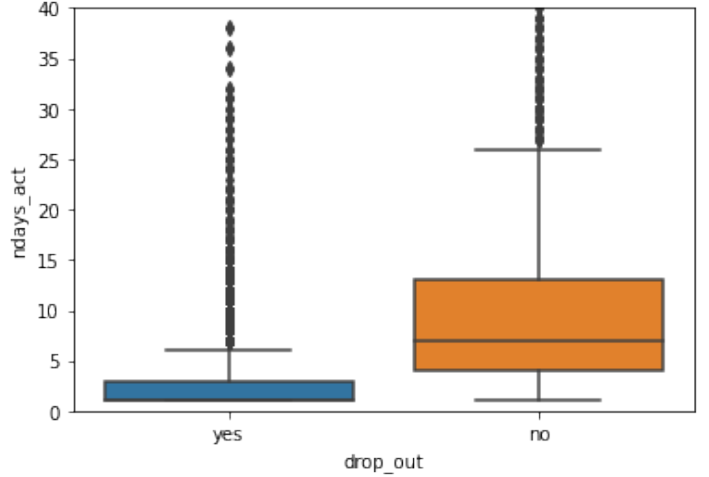
Figure 8. Average active days of dropout students and non-dropout